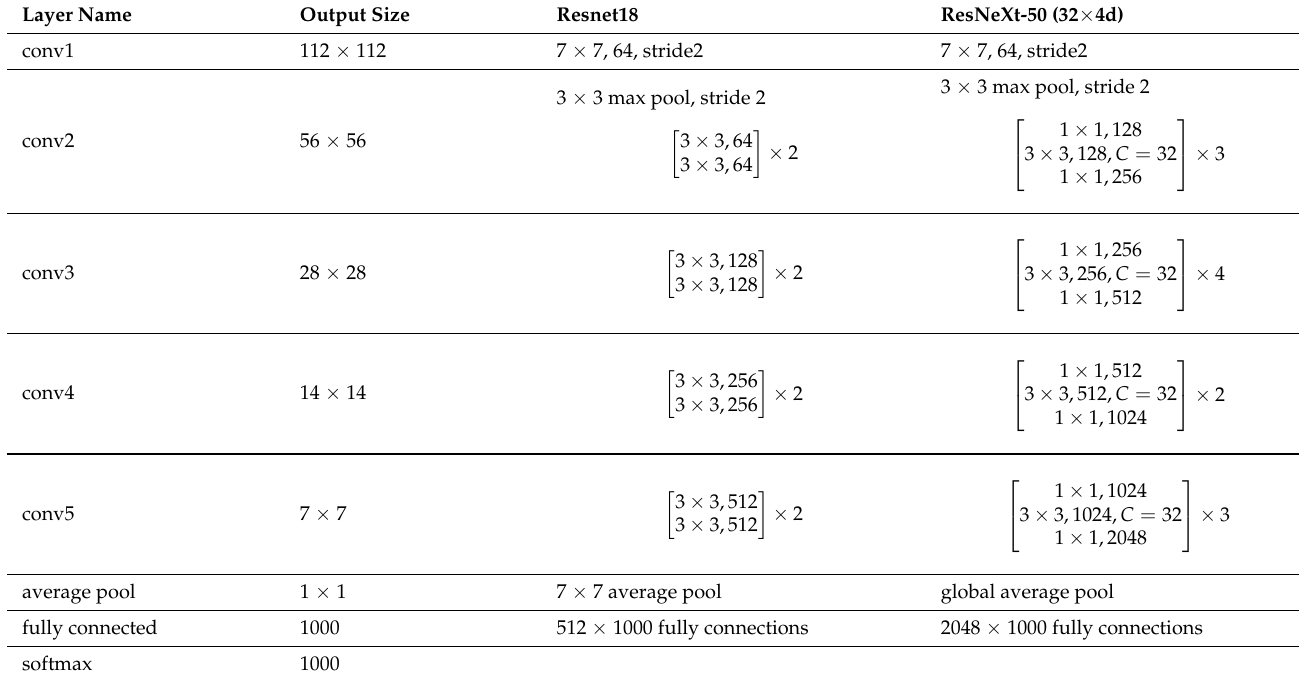
Table 4. ResNet18 and ResNeXt-50 architectures [24,26].